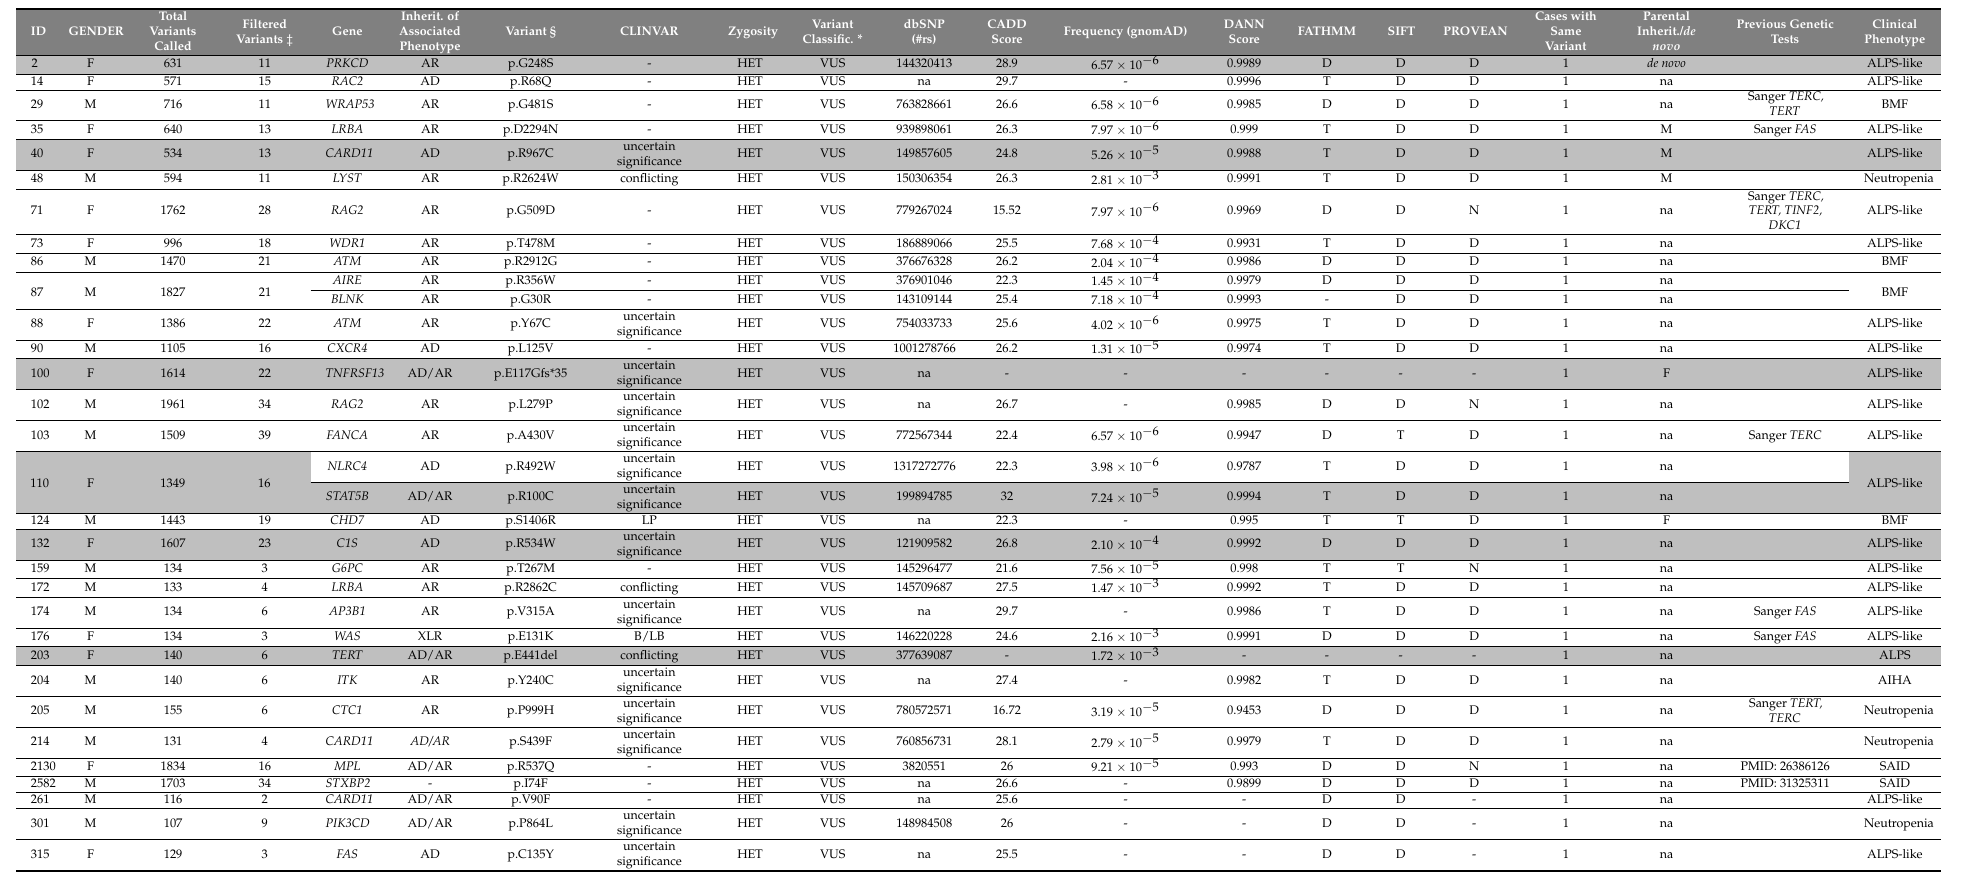
Table 2. Variants of unknown significance with a probable effect on the phenotype, detected among 272 patients affected with inborn errors of